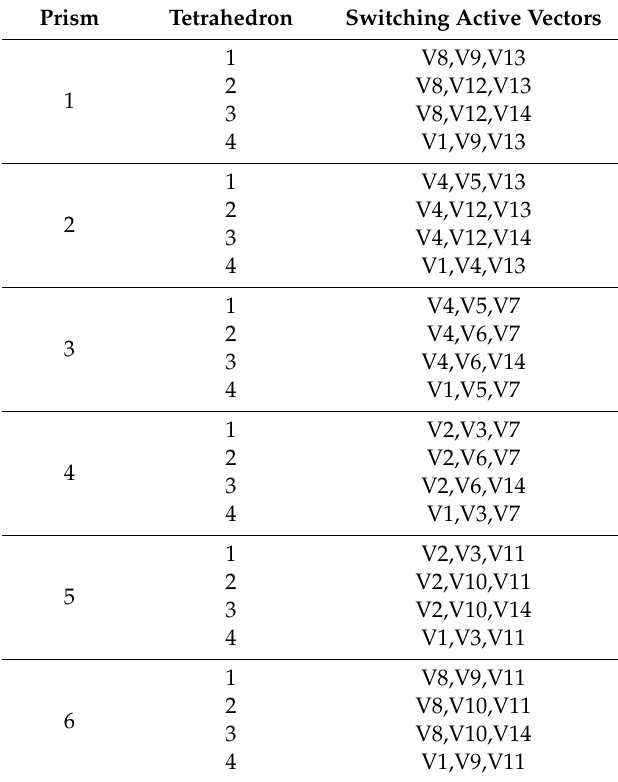
Table 3. Look up table for choosing correct switching sequence.